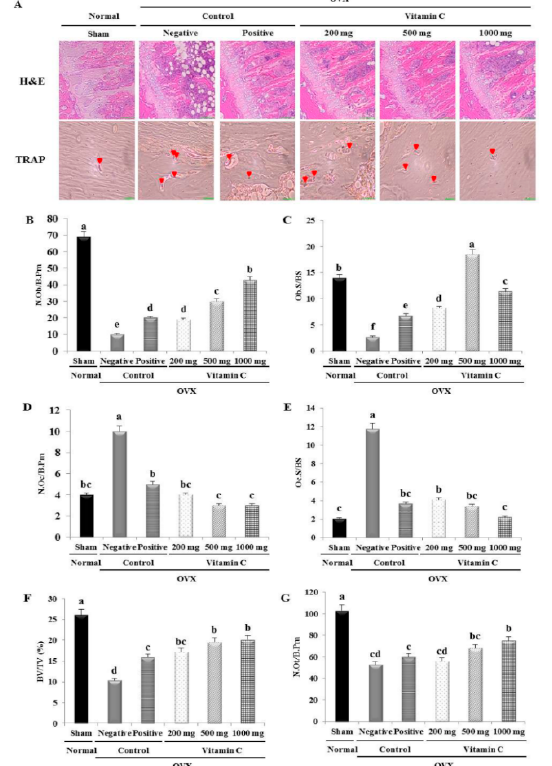
Figure 4. Effect of vitamin C on histomorphometrical analysis in OVX rat tibias: ( A ) Hematoxylin and eosin (H&E) and tartrate-resistant acid phosphatase (TRAP) staining image of the trabecular bone; Dynamic histomorphometrical analyses were performed in this same region to determine ( B ) the number of osteoblasts per bone perimeter (N.Ob/B.Pm), ( C ) osteoblast surface per bone surface (Ob.S/BS), ( D ) the number of osteoclasts per bone perimeter (N.Oc/B.Pm), ( E ) osteoclast surface per bone surface (Oc.S/BS), ( F ) the number of osteocytes per bone perimeter (N.Ot/B.Pm), and ( G ) bone volume per total volume (BV/TV). Data represent the mean ± standard deviation. Values with different letters were significantly different according to Duncan’s multiple range test ( P < 0.05).